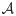
Effect of single ablations on the make-up of different partitions as measured by the community variation.(a) The disruption of every single mutation with respect to Partitions A–E is quantified through CV[i](P), as defined in Eq (14). The distribution of CV[i] is represented by its median (red line) and the inter-percentile range (IPR) between the 10th and 90th percentiles (box). The whiskers correspond to the IPR for each partition, and the single ablations detected as outliers are labelled. (b) Effect of the single ablations CV[i](P) for each partition averaged over each type: sensory (blue), inter- (red) and motor neurons (yellow). On average, single ablations of motor neurons induce larger changes on the finer Partitions A and B, whereas ablations of interneurons have a larger effect on the coarser Partitions D and E. The error bars are the standard error of the mean.